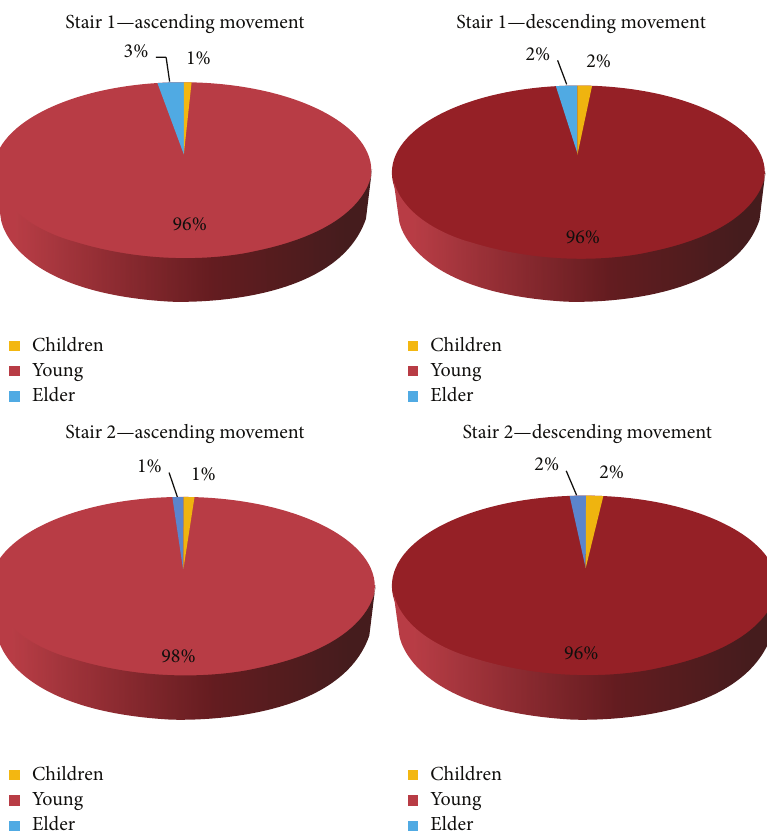
Figure 4: Age-group-wise directional pedestrian